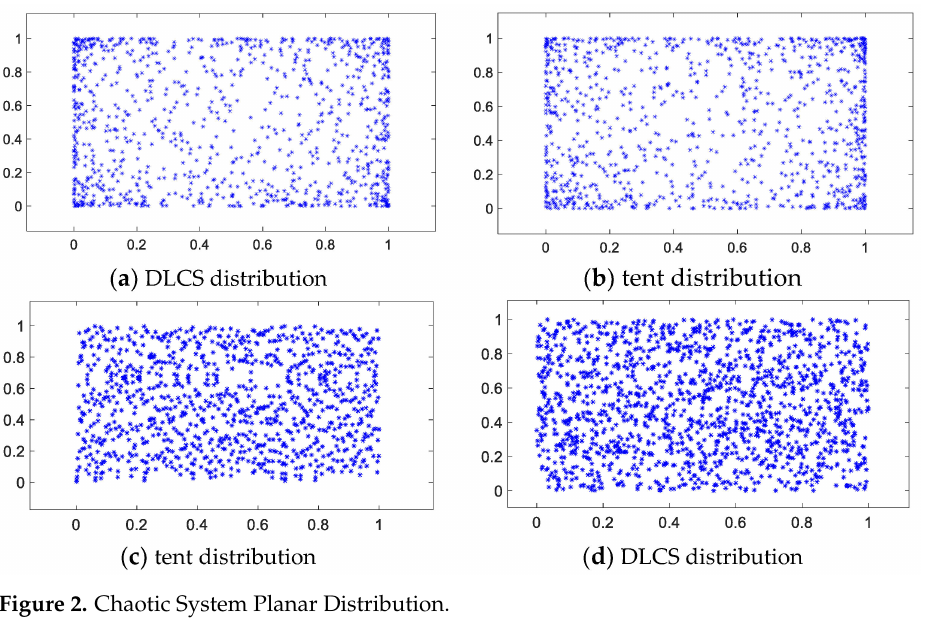
Figure 2. Chaotic System Planar